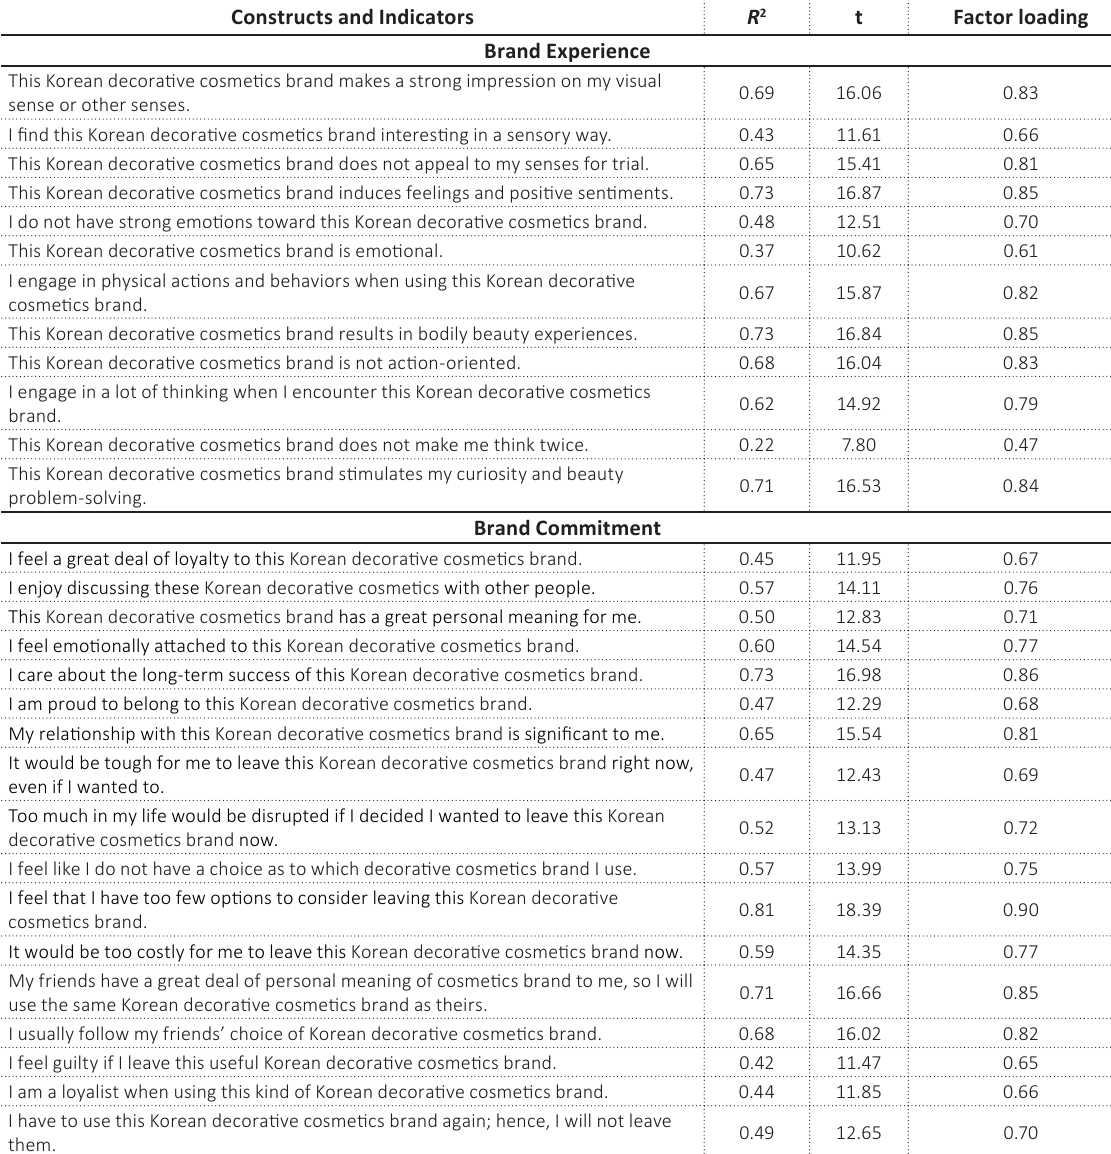
the strength of relations (paths), especially the significant ones. Table 4 shows the values for each hypothesis. Table 4. Items and their loadings Constructs and Indicators R 2 t Factor loading Brand